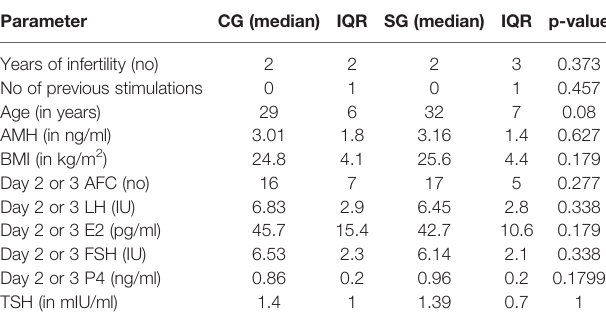
TABLE 1 | Patient ’ s characteristics.